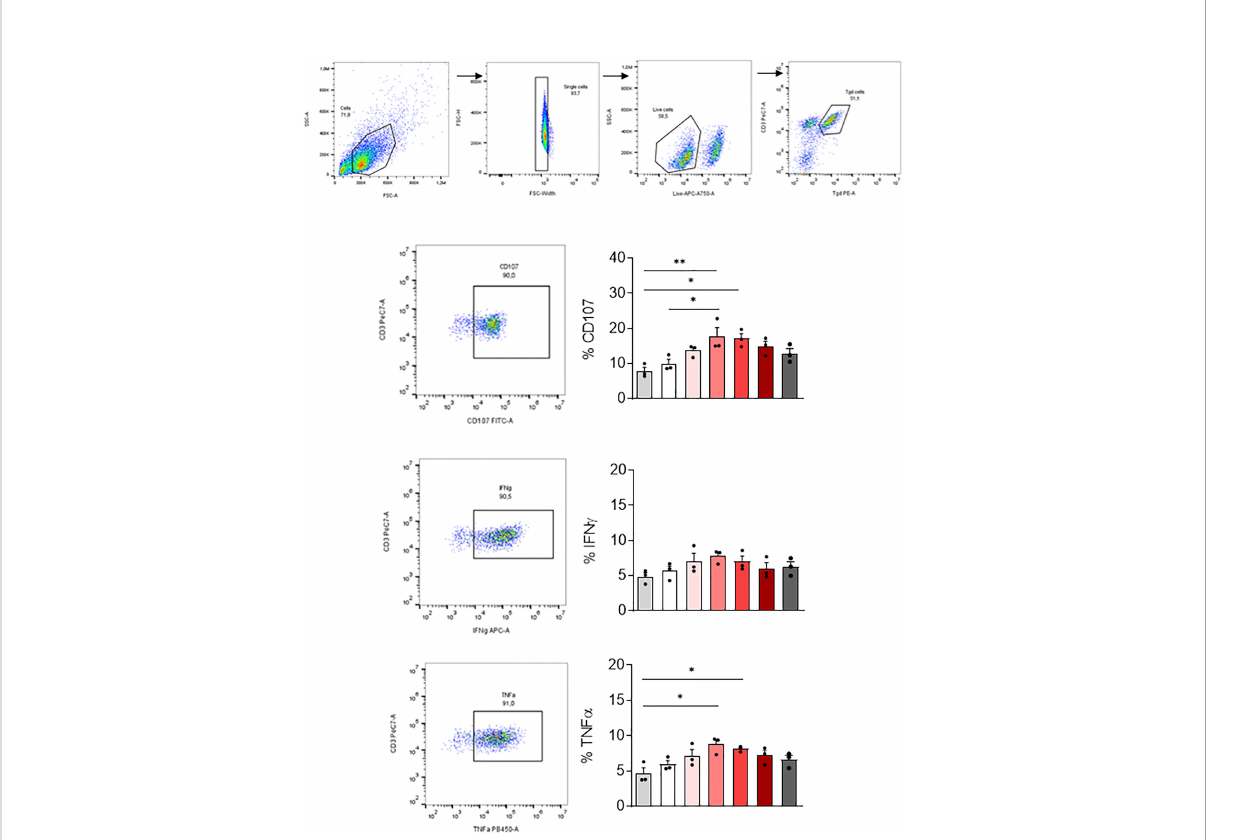
FIGURE 5 gd 2 T cell activation. MDM previously infected 24 hours with SARS-CoV-2 variants including Wuhan (China), a -B.1.1.7 (United Kingdom, UK), b - B.1.351 (South Africa, SA), g -P.1 (Brazil), d -B.1.617 (India) and B.1.1.529 (Omicron) (0.1 MOI) were co-cultured with autologous gd 2 T cells (E:T ratio of 1:1). gd 2 T cell degranulation (% CD107ab + cells) and intracellular TNF a and IFN g , respectively, were assessed after 4 hours of co-culture in the presence of GolgiStop and analyzed by fl ow cytometry. Manual gating to identify gd 2 T cell population (CD3 + TCRV d 2 + ). The percentage of CD107 + , IFN g + and TNF a + cells, were then gated in the gd 2 cell population (CD3 + TCRV d 2 + ). Data values represent the mean ± SD from 3 healthy donors. Statistical analysis was performed with one-way ANOVA and Tukey ’ s multiple comparison test. * p ≤ 0.05 and ** p ≤ 0.01